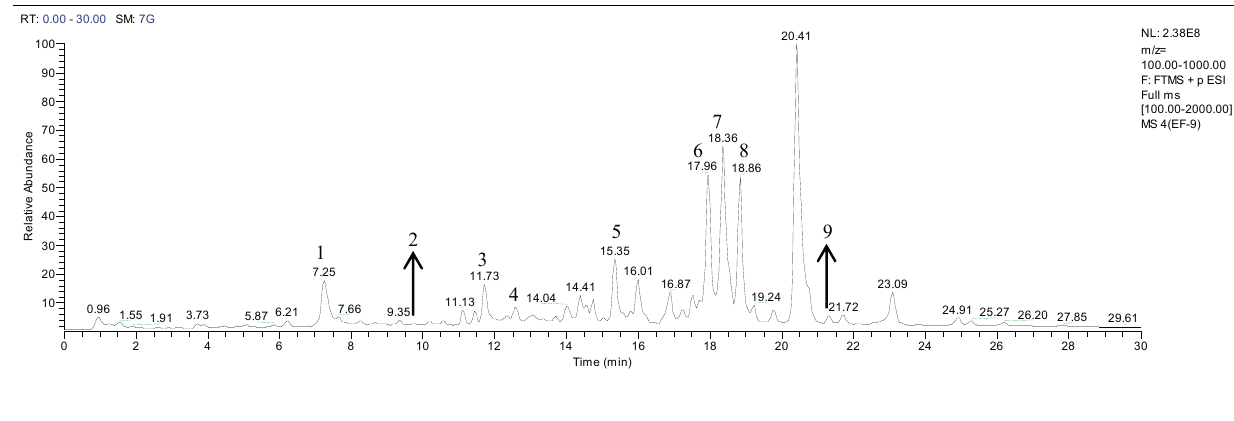
Figure 2. Representative total ion current chromatogram in positive ion